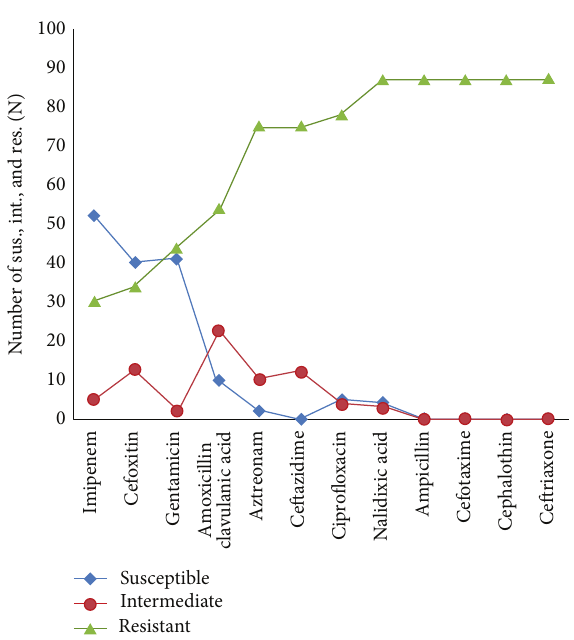
Figure 1: Antimicrobial resistance of ESBL-producing Klebsiella pneumoniae isolates was measured by disk diffusion method. Table 2: Prevalence of the plasmid-mediated quinolone resistance genes among extended-spectrum 𝛽 -lactamase-producing Klebsiella pneumoniae